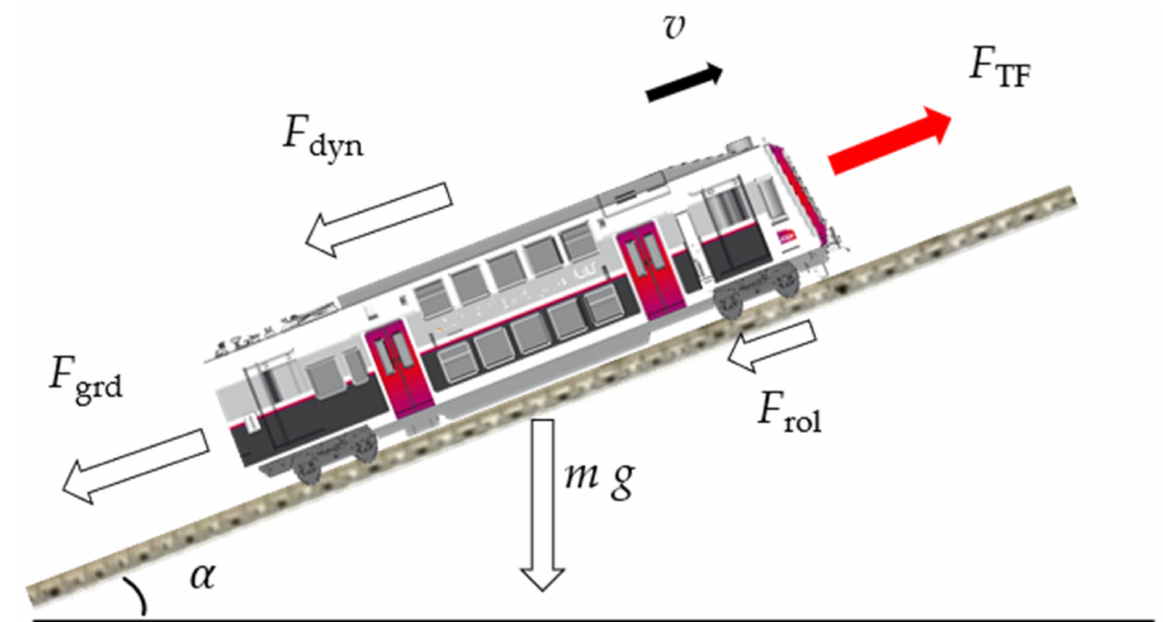
Figure 11. Representation of the forces involved in the movement of the